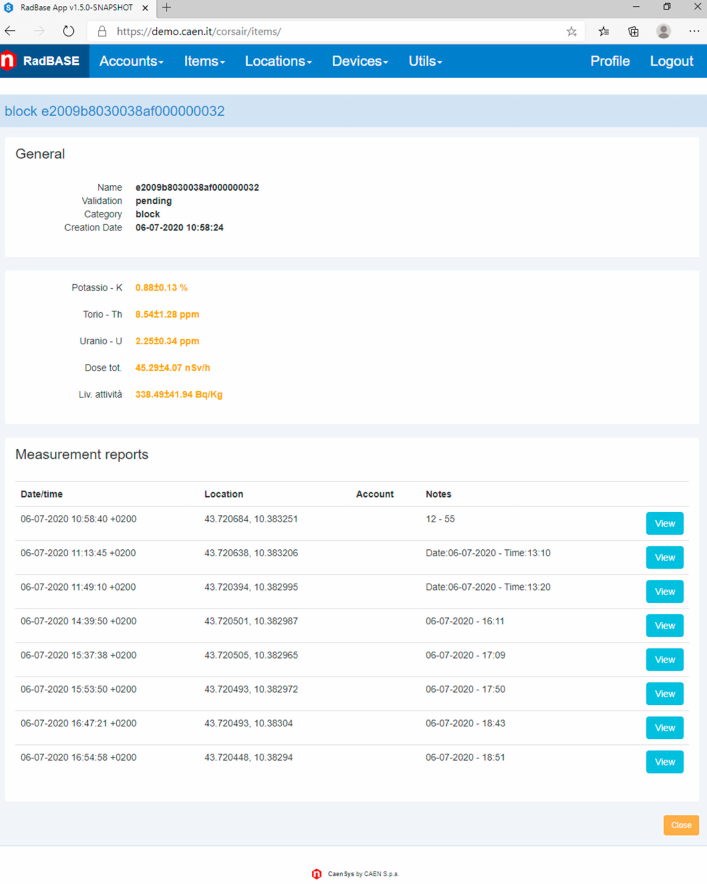
Figure 2. Cloud platform WEB page showing information about a block previously registered and